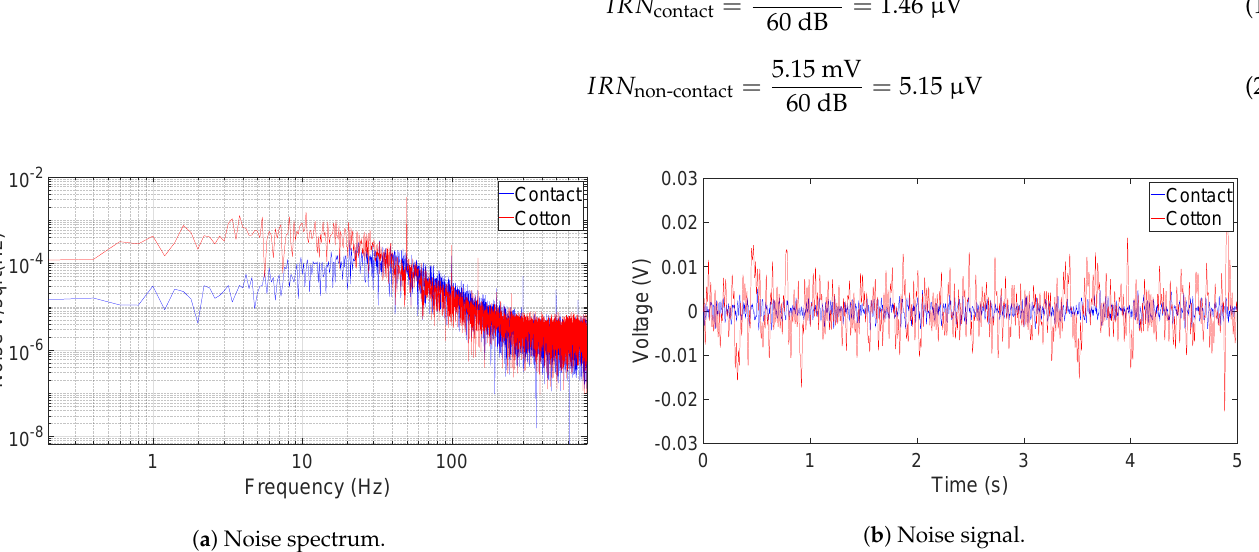
Figure 6. Output noise of the AFE when the inputs are grounded (blue) and coupled to GND through a later of cotton